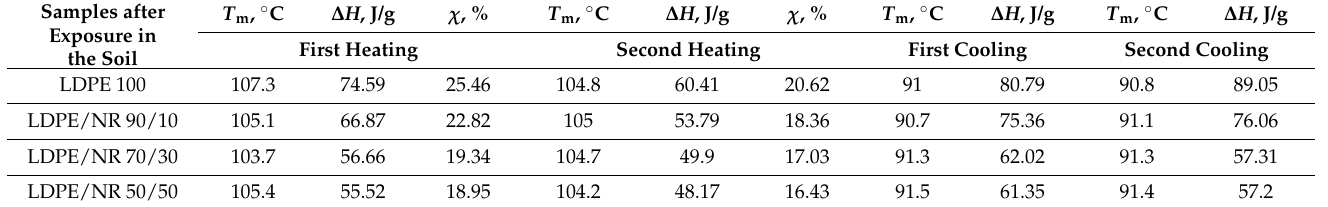
Table 6. Differential scanning calorimetry of the samples after exposure in the soil.